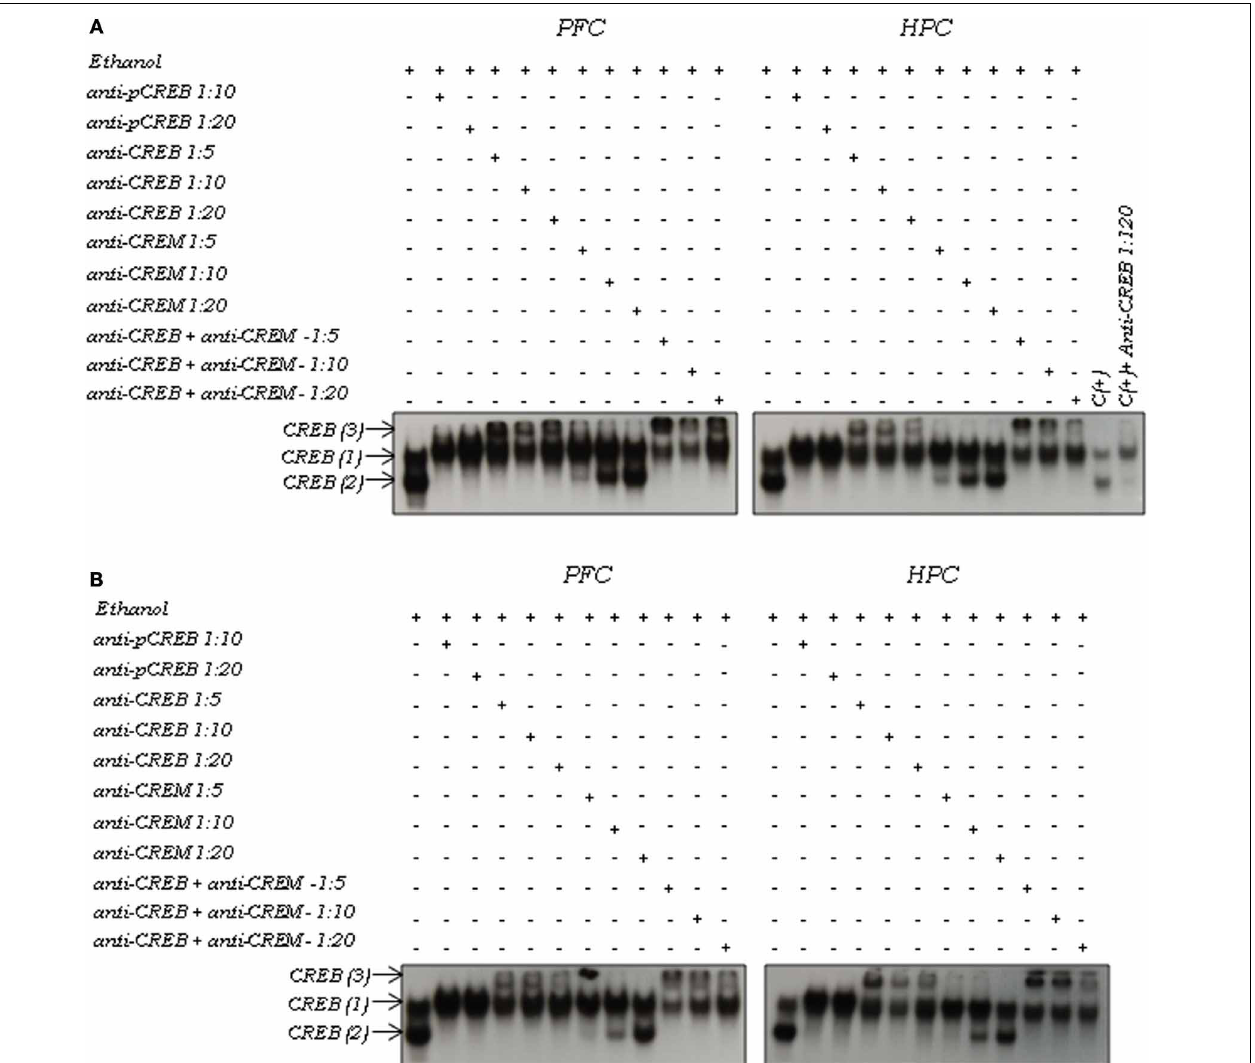
FIGURE 3 | Supershift assay of CREB activation induced by ethanol in the prefrontal cortex (PFC) and hippocampus (HPC) in (A) adult and (B) adolescent mice using the EMSA. Nuclear extracts (10 μ g) were obtained 3h after an acute 2.0g/kg ethanol injection. Extracts were incubated in the absence ( − ) or presence ( + ) of antibodies